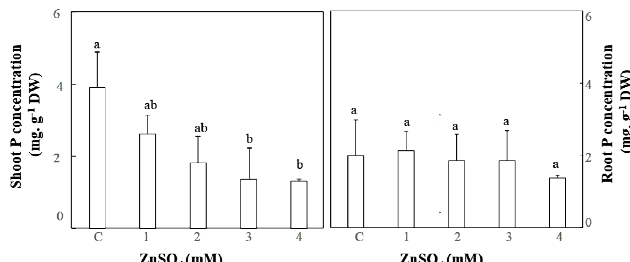
Fig. 5: Shoot and root phosphorus content of fenugreek plants grown with different ZnSO 4 concentrations for 52 days. Values (means ± SE of three replicates) followed by the same letter are not significantly dif - ferent (Duncan test, P =